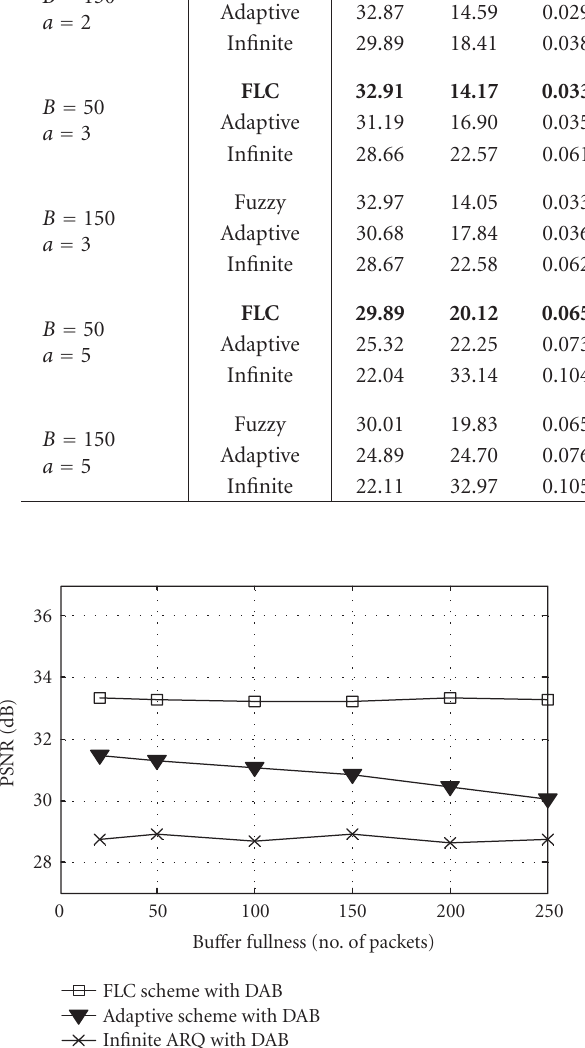
Figure 13: Mean PSNR for three DAB-based schemes with chang- ing bu ff er